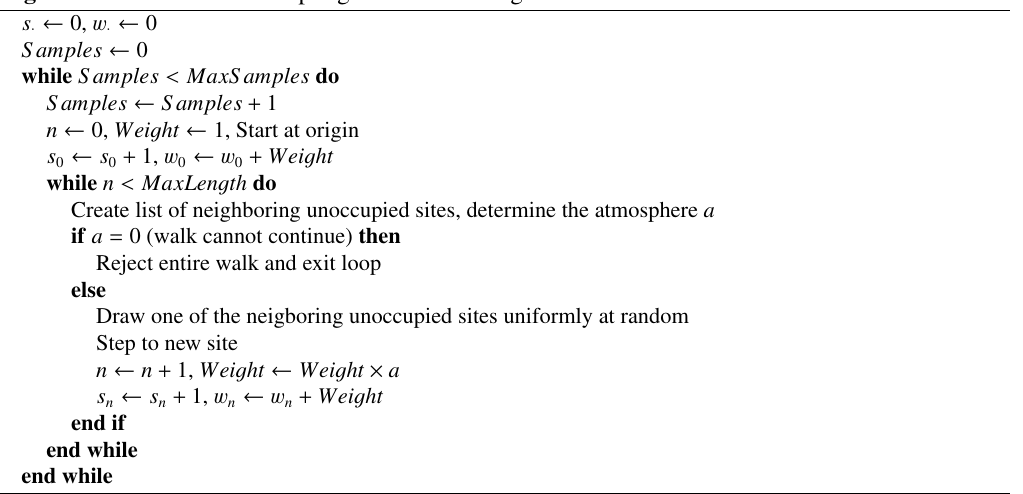
Algorithm 2 Rosenbluth Sampling of Self-Avoiding